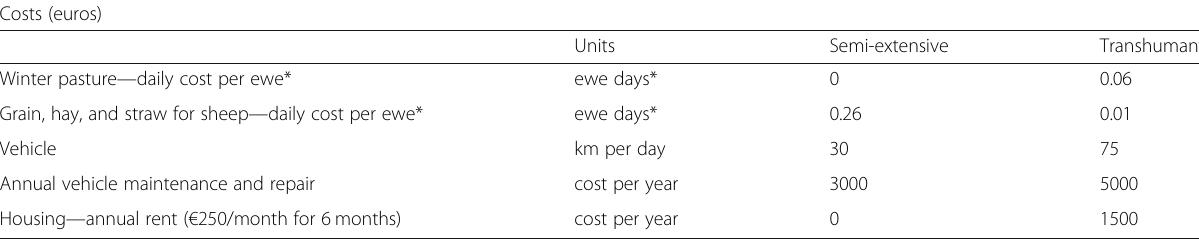
Table 1 Costs that vary between semi-extensive and transhumant operations. At the time of data collection in fall 2018, 1 euro =